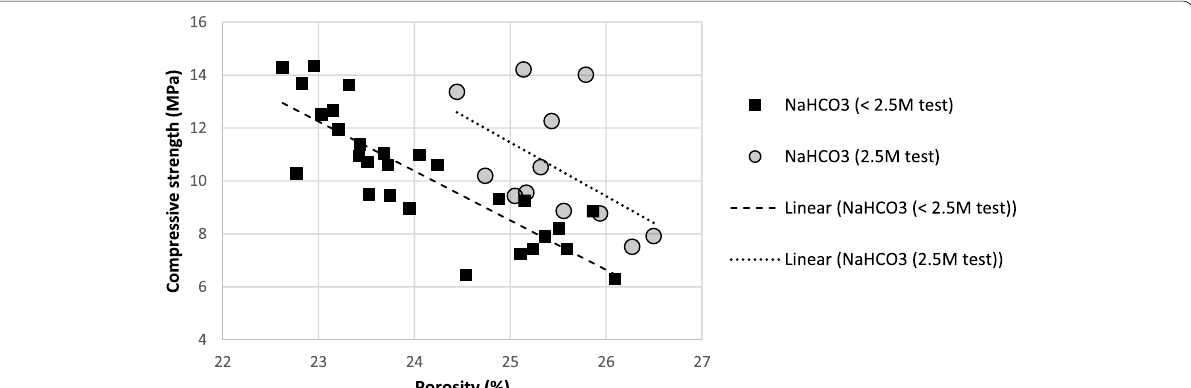
Fig. 3 Compressive strength versus porosity: NaHCO 3 treated specimens, segregated by early or late compressive strength test performance (“X M treat” treated X months after casting; “Y M test” =